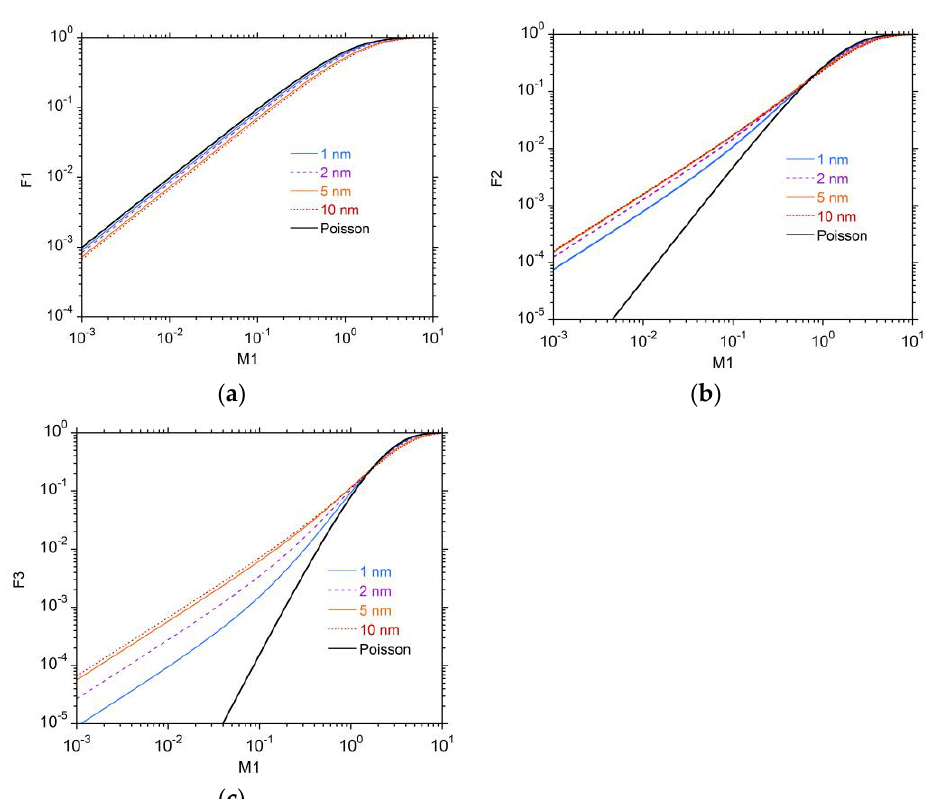
Figure 2. The cumulative probabilities F k ( M 1 | D ) calculated at different site sizes and compared with the corresponding values deriving from a pure Poisson distribution for the probability of